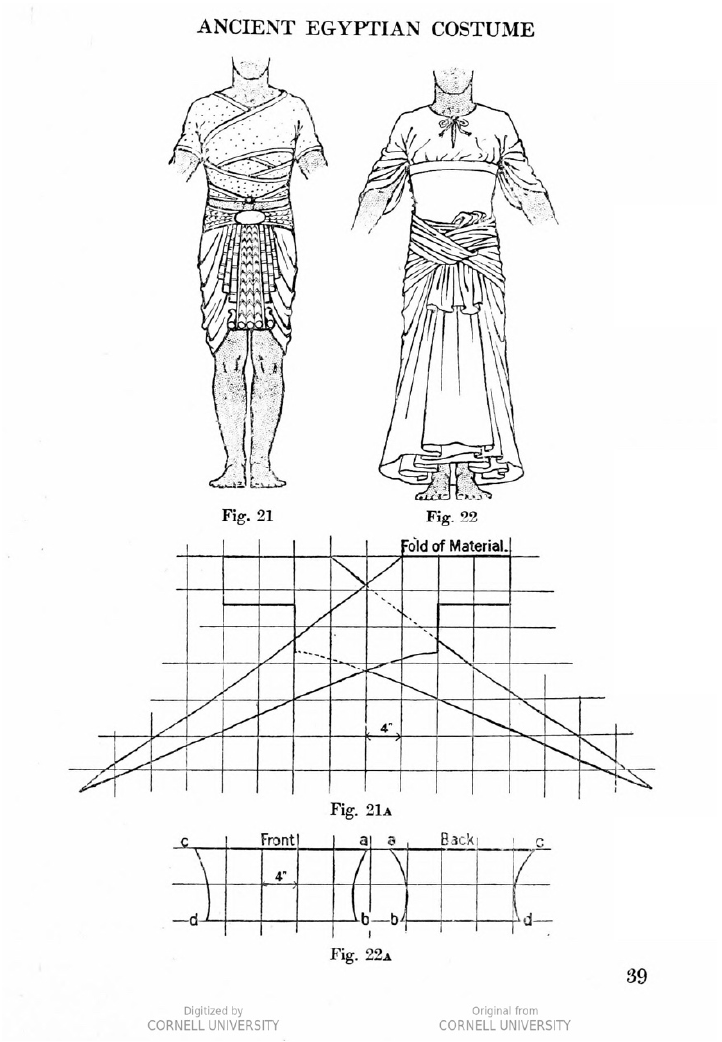
Figure 3. Technical costume manual depicting ancient Egyptian belts with appendages. From (Houston and Hornblower 1920, p. 39). (Courtesy of HathiTrust).